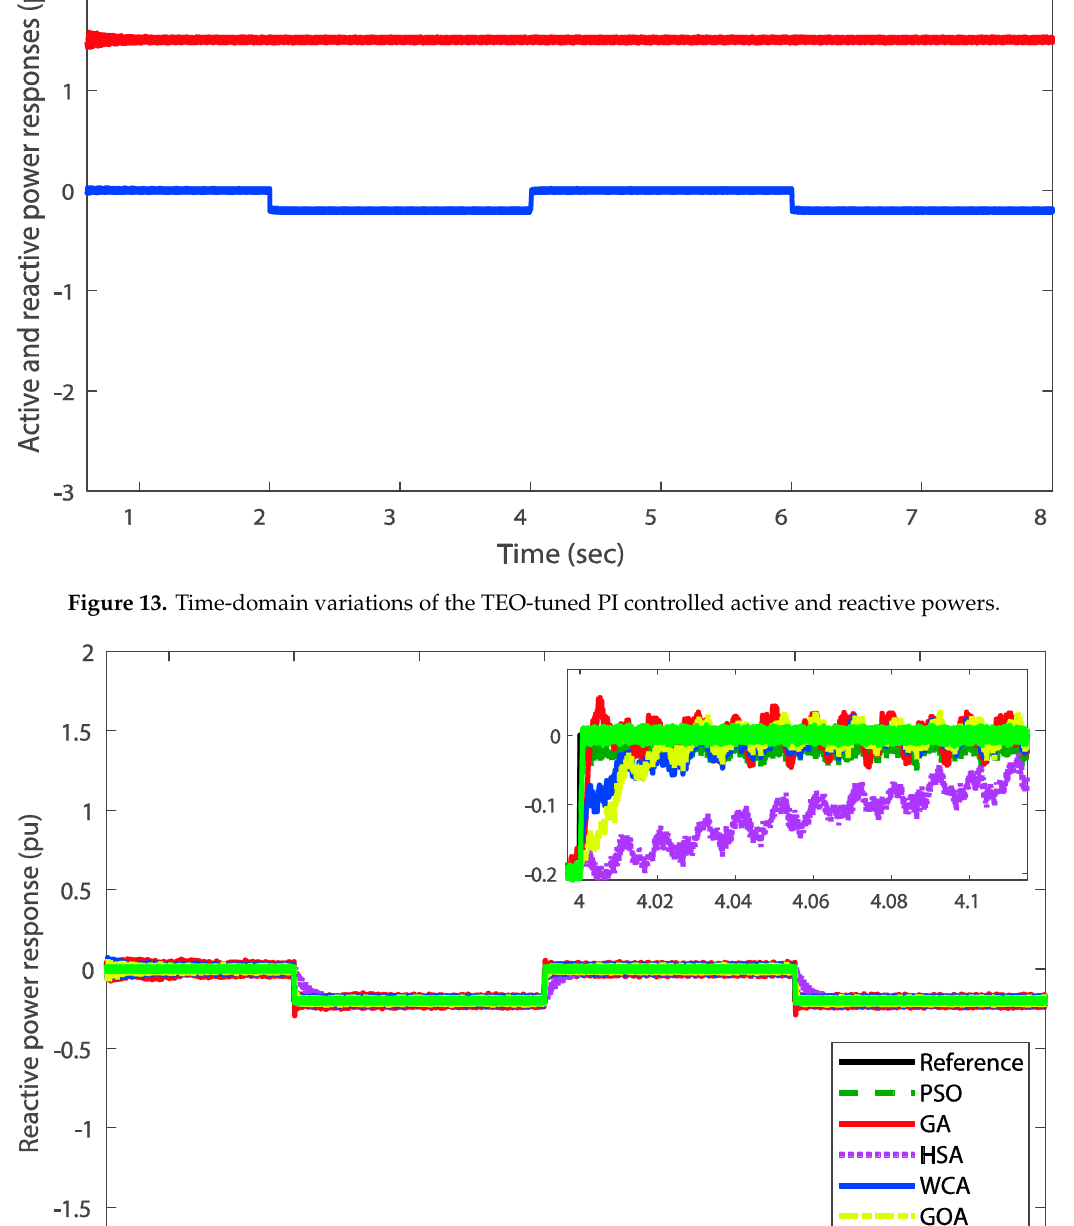
Figure 15. Time-domain variations of the TEO-based control of the direct and quadrature rotor currents. 6.2. Statistical Analysis and Comparison In this part, the mean execution values related to the different optimization criteria are sorted to assess the best operating one according to its average objective function performance. Moreover, a statistical comparison based on the nonparametric Friedman and Bonferroni–Dunn is carried out by using these mean performances [30,31]. The average ranks for all the proposed methods based on the four performances indices are provided in Table 6. One can note that the proposed TEO metaheuristic has worthily attained the lowest average ranks compared to the remaining methods. A statistical analysis has been performed to highlight the importance of the TEO-based tuning method over other algorithms [32].